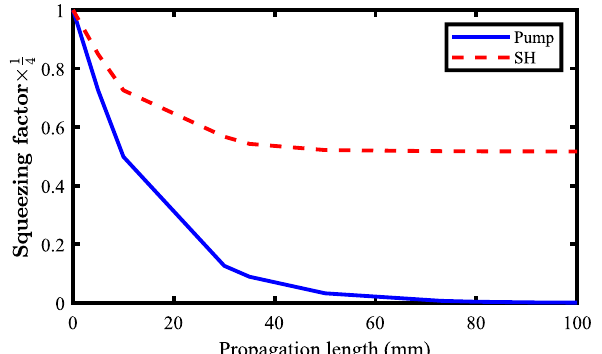
Figure 4. Quadrature squeezing for the pump (blue-solid line) and the SH mode (dashed-solid line) when just 10 non-uniform coarse steps are used to examine the stability of the method.